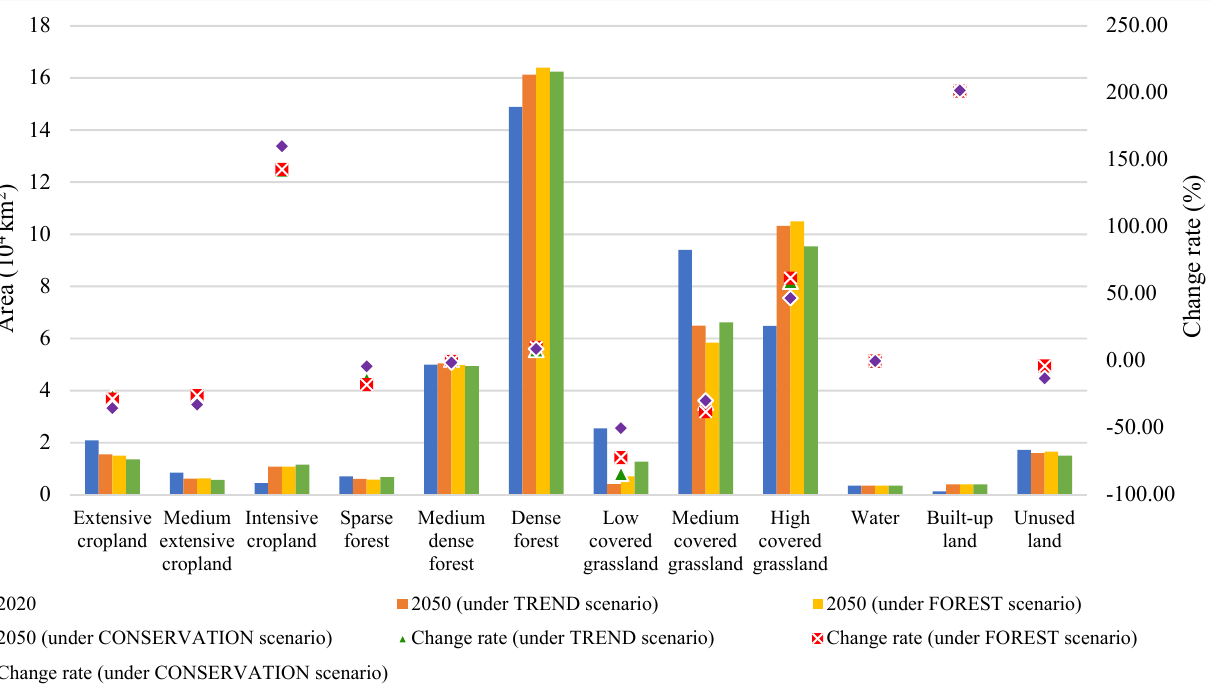
Figure 5. Variation of each land system type under different scenarios (2050) in the Hengduan Mountain region.